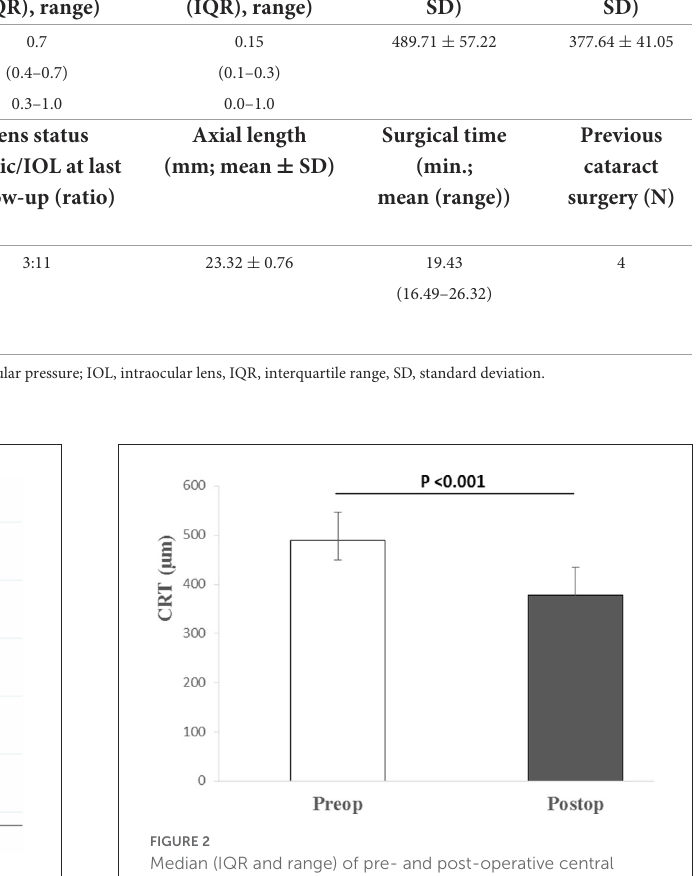
FIGURE1 Median (IQR and range) of pre- and post-operative best corrected visual acuity (logMAR) results. Preop., pre-operative; Postop., post-operative.